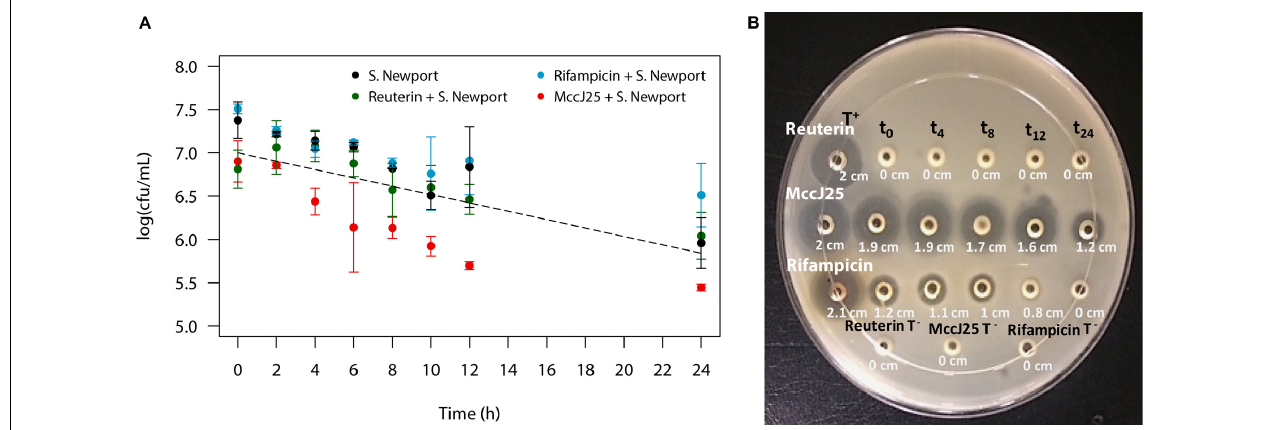
FIGURE 3 | Quantification of the inhibitory activity of MccJ25 against Salmonella enterica subsp. enterica serovar Newport ATCC 6962 under swine colonic fermentation in the PolyFermS model. (A) Washout of Salmonella Newport from continuous culture of porcine colonic microbiota in the PolyFermS model starting from 10 7 CFU/mL. Salmonella Newport washout over 24 h as quantified by PMA-qPCR, in absence of antimicrobial compound ( ) and in presence of MccJ25 at a (cid:32) concentration of 0.397 mM ( ), reuterin at 4 mM ( ) and rifampicin at 0.608 mM ( ). The dashed line represents the theoretical washout of inert particles starting at (cid:32) (cid:32) (cid:32) 10 7 per mL. Error bars indicate standard deviation based on two independent repetitions in test reactors 1 and 2. Plotted values are based on PMA-qPCR analysis.